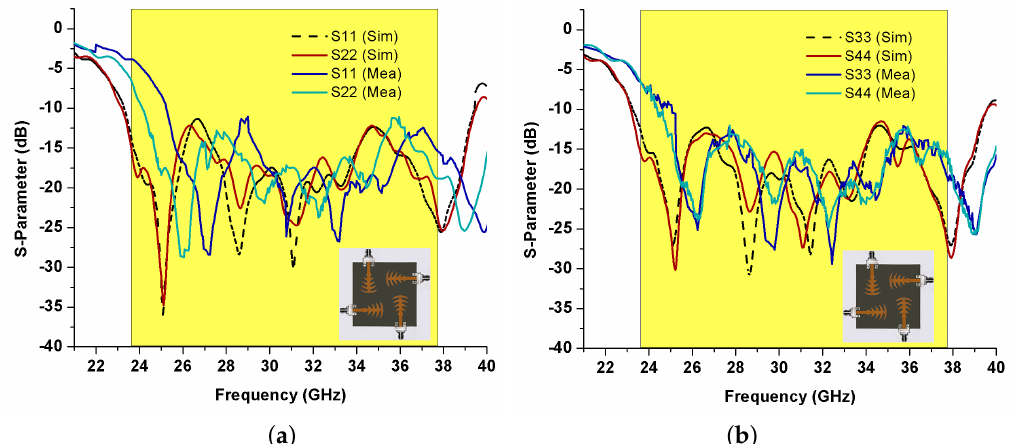
Figure 8. Proposed wideband MIMO antenna reflection coefficients: ( a ) port 1 and 2; ( b ) port 3 and 4.